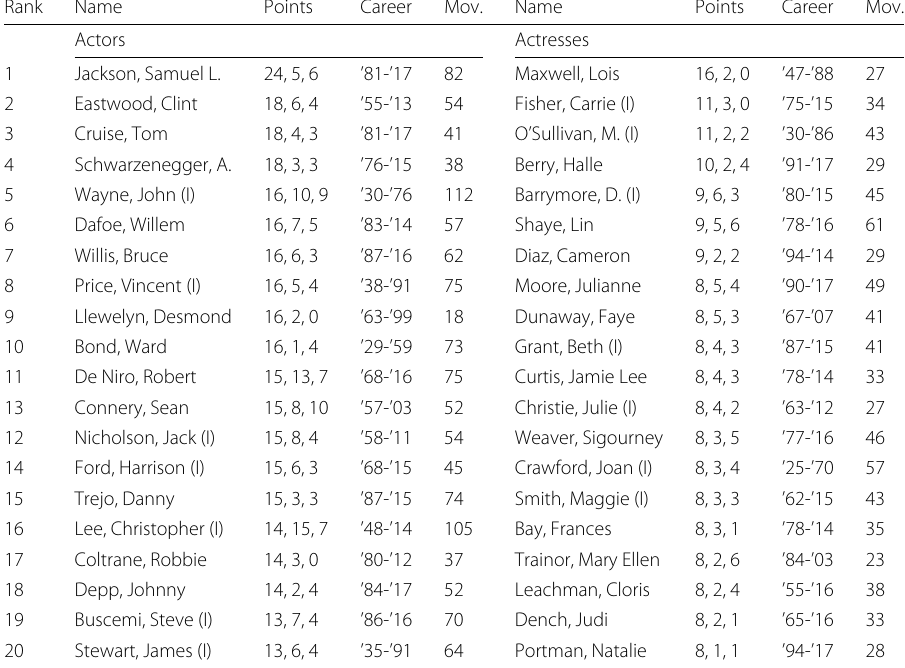
Table 8 Top 20 actors and actresses: each item contains the number of golden (G), silver (S) and Bronze (B) points collected, the year of the first and last movies, and the number of films starred